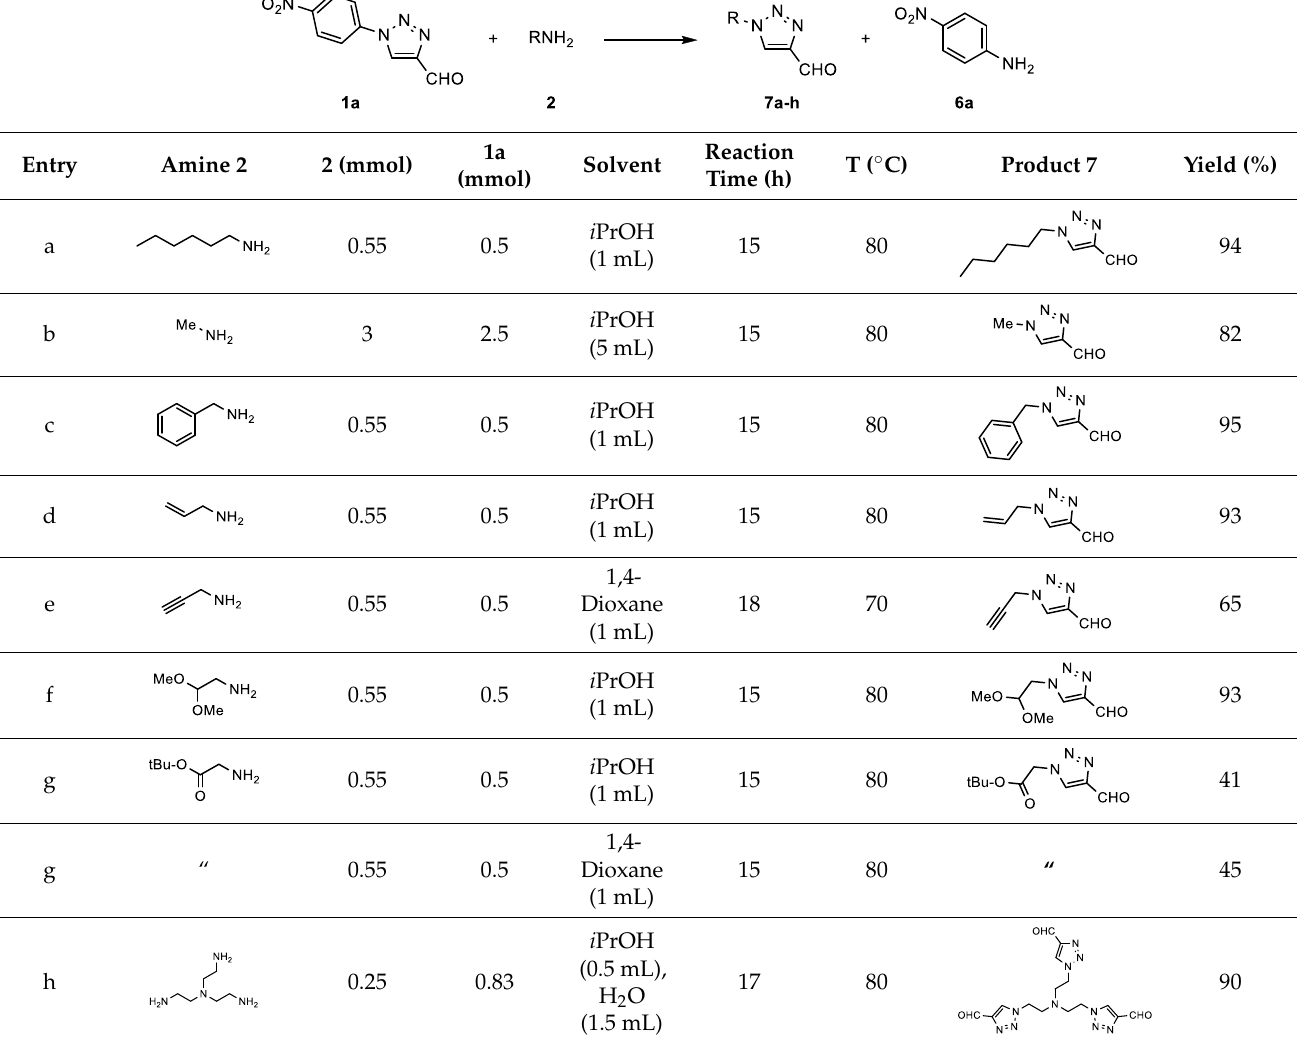
Table 1. Synthesis of 1-alkyl-4-formyl-1,2,3-triazoles 7a-h from primary amines 2 and FNPT 1a : Reaction conditions and yields.